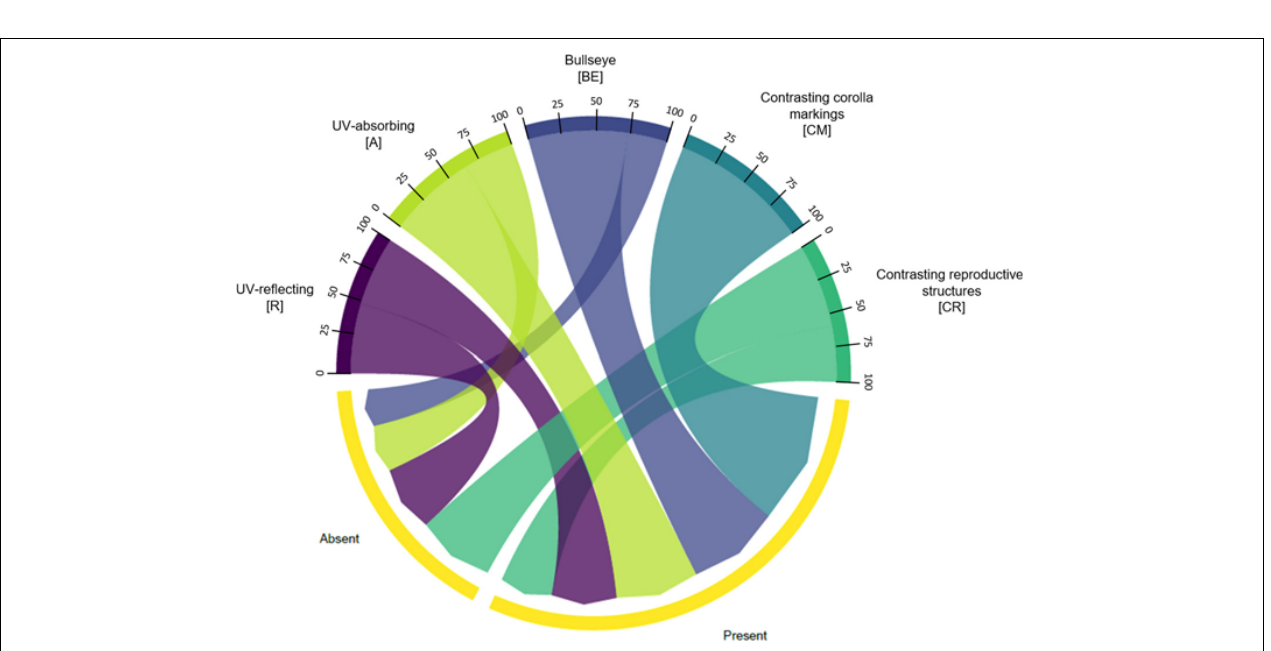
FIGURE 11 | Chord diagram showing the relationship between the types of floral UV features and the presence/absence of non-UV colour patterns of 80 plant species. The chords are unidirectional. Chord thickness corresponds to the percentage of species with UV features that is related to a presence/absence of non-UV colour pattern. Flowers within each UV category presented similar percentages of species with presence/absence of non-UV colour patterns ( χ 2 = 6.7744; p = 0.1483). See Supplementary Table 9 for percentages. R, non-patterned UV-reflecting; A, non-patterned UV-absorbing; BE, bullseye; CM, contrasting corolla markings oriented towards floral resources; CR, contrasting reproductive